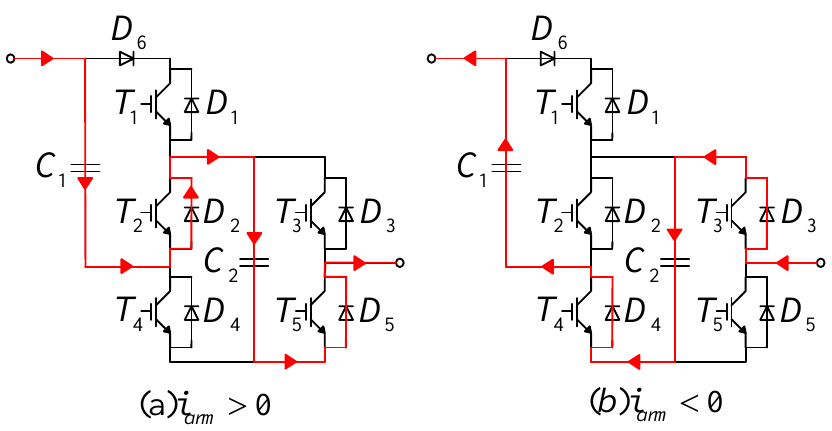
Figure 3. Current path when the fault is blocked: ( a ) i arm > 0; ( b ) i arm < 0. In summary, the operation mode of CHBFBSM can be divided into five normal modes and two blocking modes. The switch state of the device in each mode is shown in Table 2. Table 2. Operation mode of CHBFBSM.